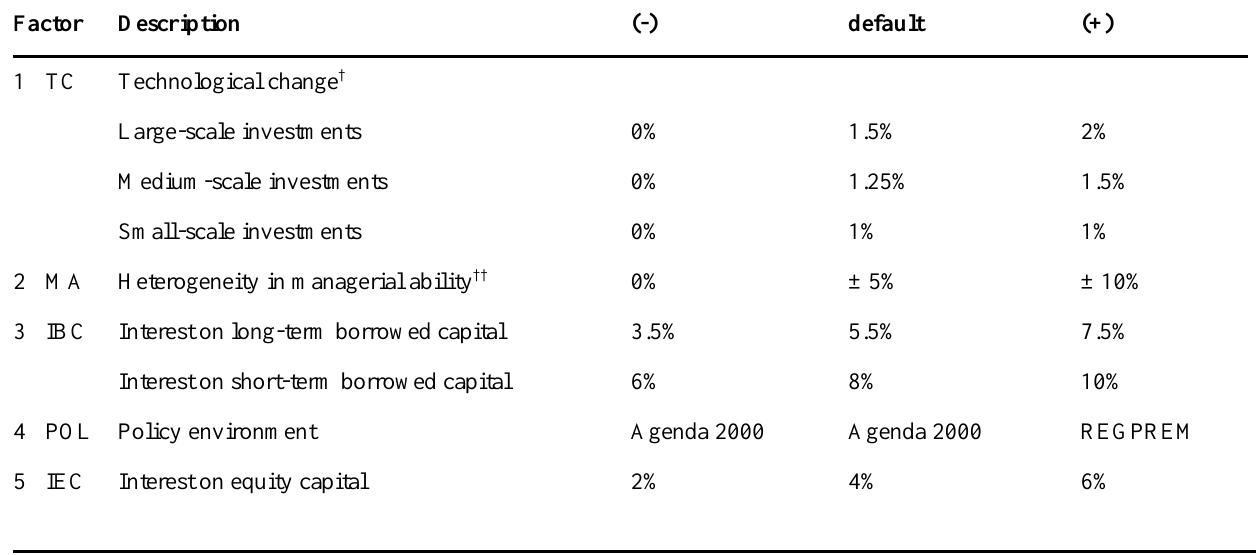
Table 5. Factor level settings with low (-), default, and high (+) factor settings. Note: † Cost savings; †† Cost savings support range around standard production costs. IBC stands for interest on borrowed capital, IEC stands for interest on equity capital, MA stands for cost savings due to managerial ability, POL stands for the policy scenario, and TC stands for technological